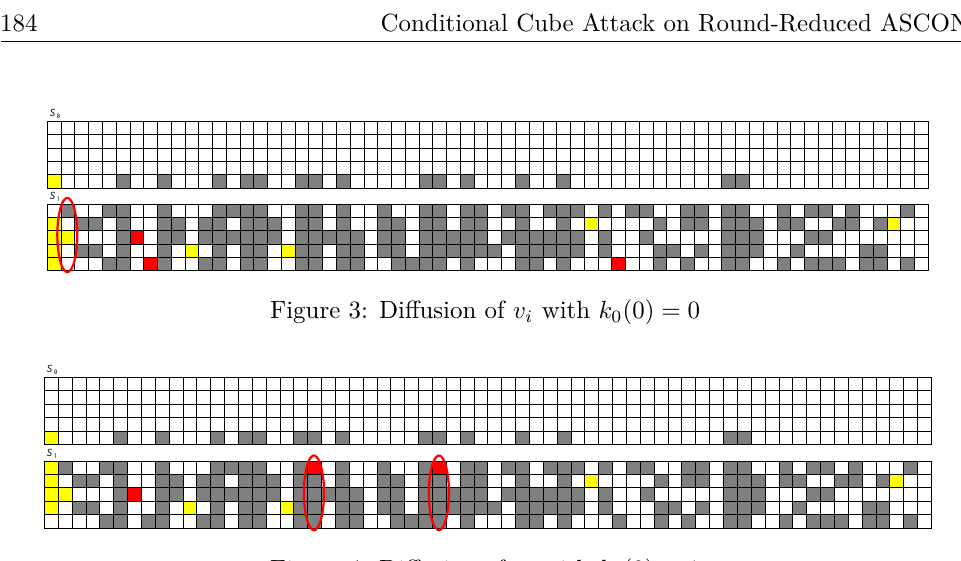
Figure 4: Diffusion of v i with k 0 (0) =